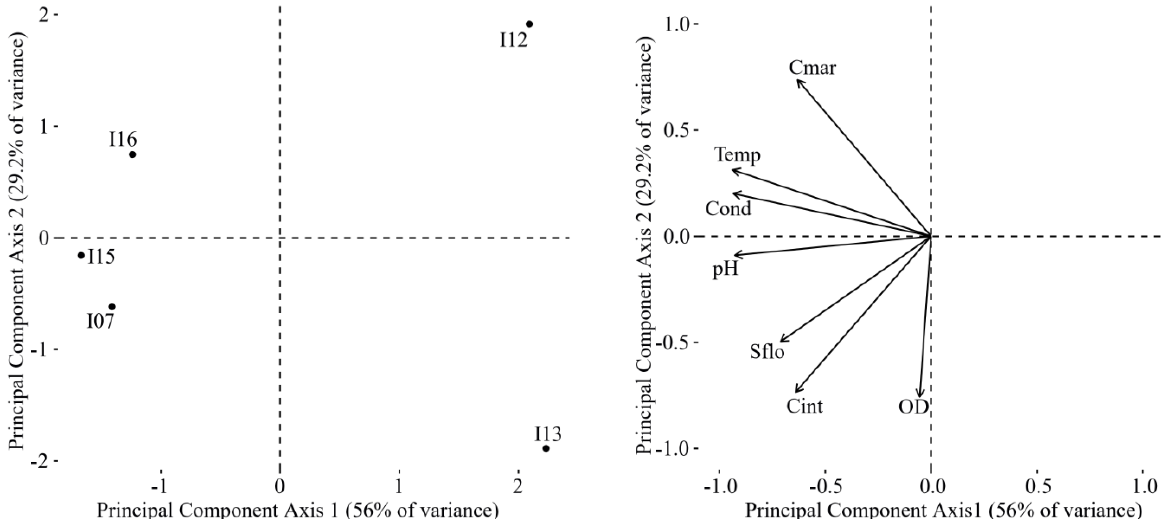
Figure 4. Biplot of the Principal Component Analysis (PCA) generated from the environmental variables obtained from five impoundments in Itauçu (I07, I12), Inhumas (I13) and Goiânia (I15 and I16), Goiás, Brazil. Environmental variables: Cint = percentage of vegetation cover –inland-, Cmar = percentage of vegetation cover -at the edge-, Sflo = percentage of soil with forest vegetation within a radius of 500 meters, Temp = temperature, Cond = conductivity, OD = dissolved